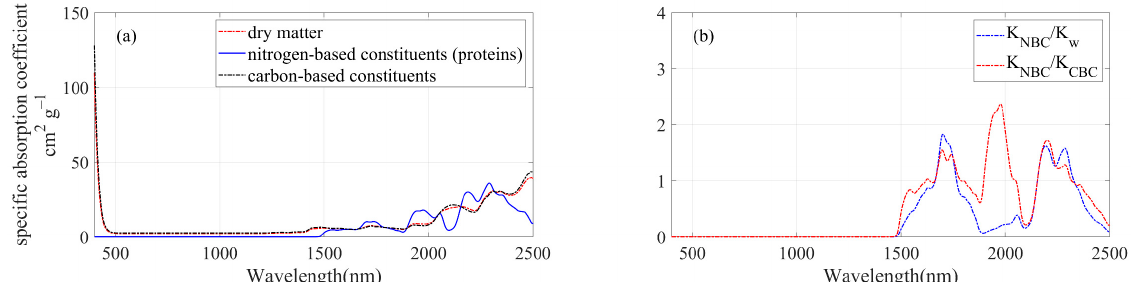
Figure 8. Specific absorption coefficients: ( a ) Of dry matter, nitrogen-based constituents (proteins), and carbon-based constituents in radiative transfer model PROSPECT-PRO and relative absorption. ( b ) Of nitrogen-based constituents to water (K NBC /K w ) and nitrogen-based constituents to carbon- based constituents (K NBC /K CBC ).